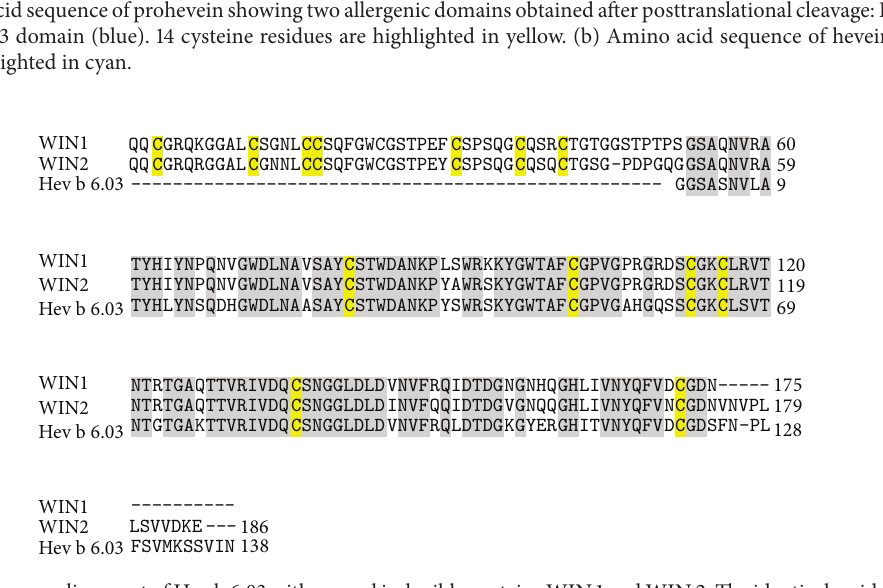
Figure 6: Multiple sequence alignment of Hev b 6.03 with wound inducible proteins WIN 1 and WIN 2. The identical residues are highlighted in grey and the cysteine residues in